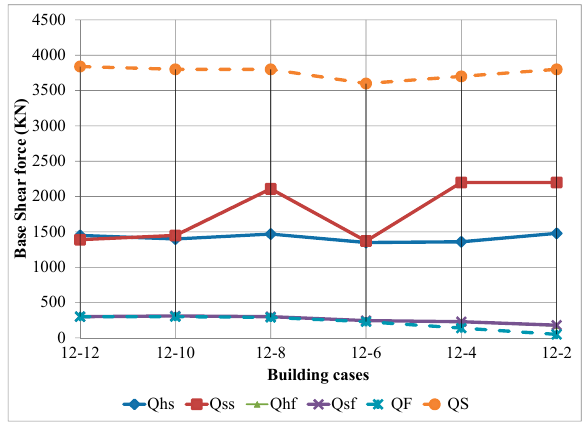
Figure 7. Base shear force in buildings with different configurations.